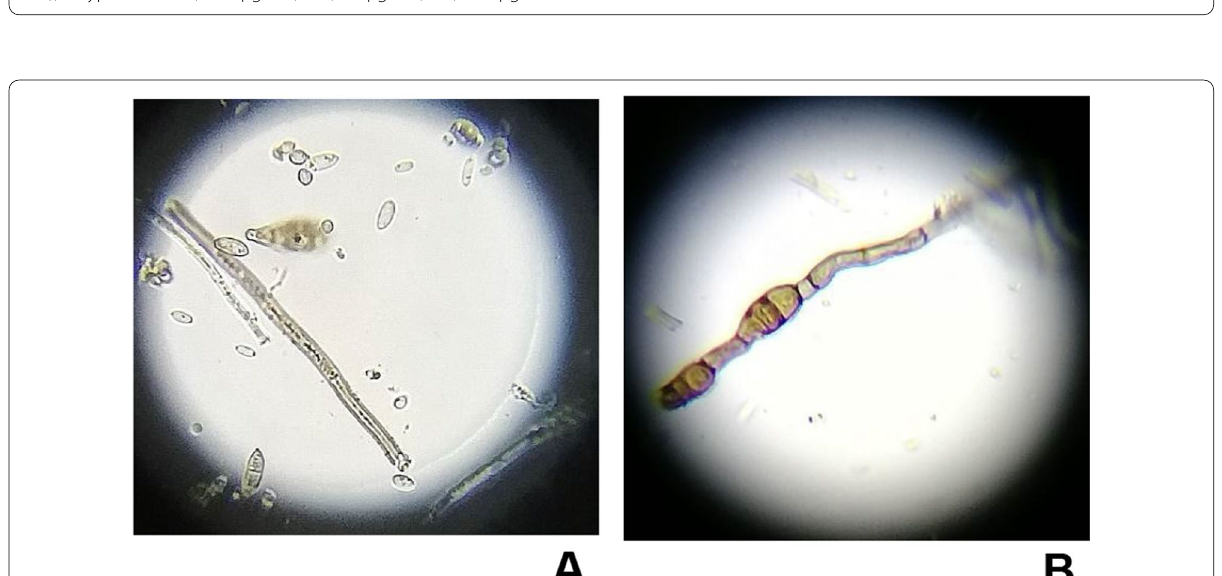
Fig. 5 Microscopic observation of hyphal morphology of ( A ) B. cinerea from the blank control observing regular hyphae and ( B cultures treated with compound 4 showing deformed mycelia with internal vacuoles of B.